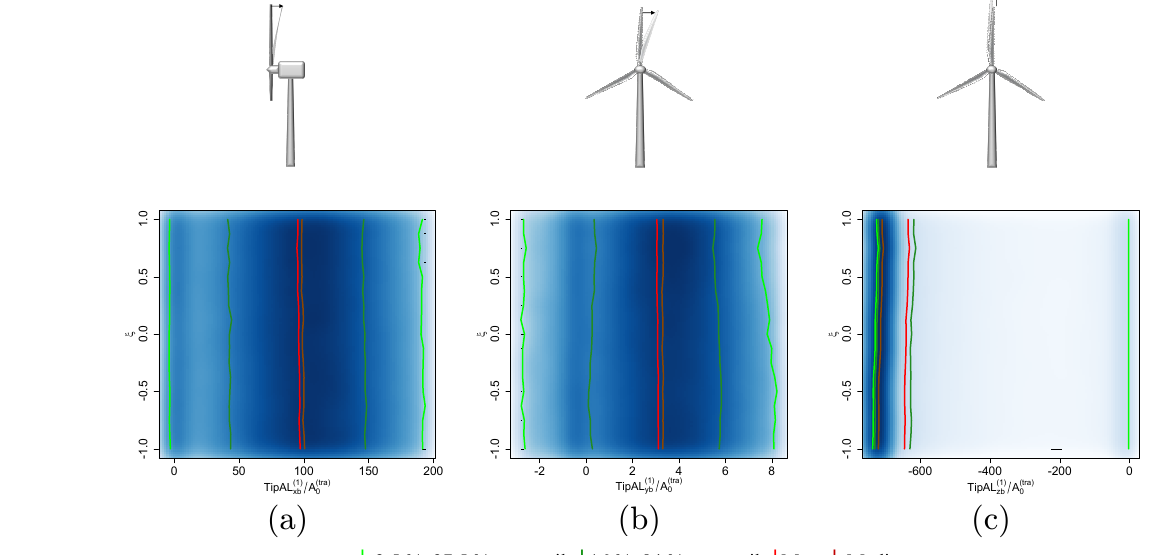
Figure 2. Variation with ξ of the PDFs of the blade tip’s translational accelerations. (a) Streamwise. (b) Spanwise. (c) Radial. The parameter ξ is represented by the vertical axis, starting with an entirely positive shear at the bottom (where ξ = − 1) and ending with an entirely negative shear at the top (where ξ = 1). The horizontal axis represents values of translational acceleration of the tip of the blade 1 (TipAL (1) ) normalized by a reference ( A (tra) ). The background color is deeper where values are more concentrated. The red line and the dark red line 0 connect the mean and the median values, respectively. The green lines and the dark green lines delimit the zones encompassing 95 and 68% of the values,